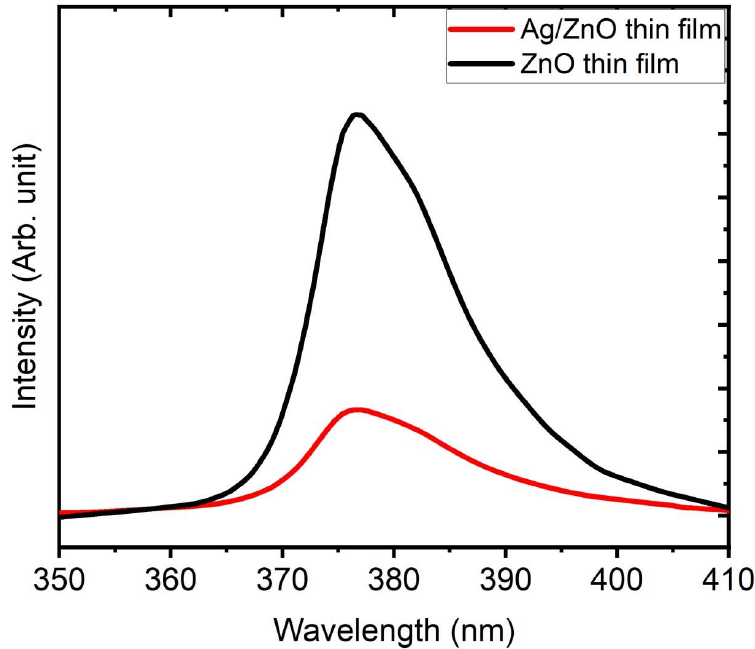
Figure 5. PL spectra of ZnO thin film before and after being embedded with Ag thin films